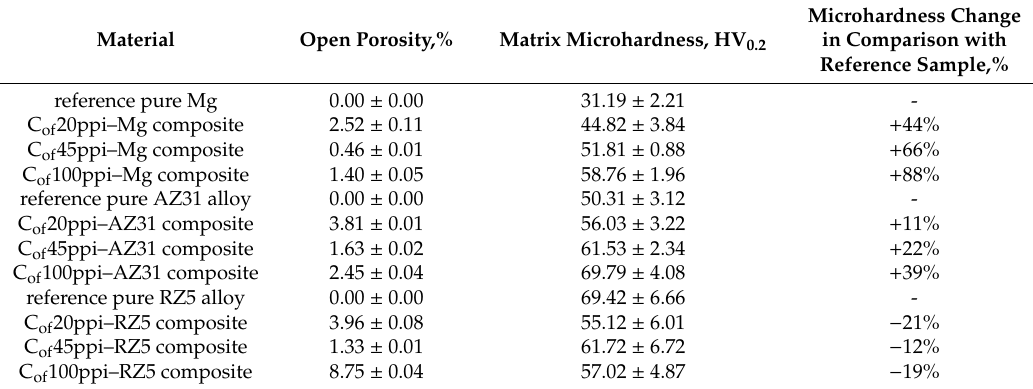
Table 2. Composite porosity results and matrix microhardness